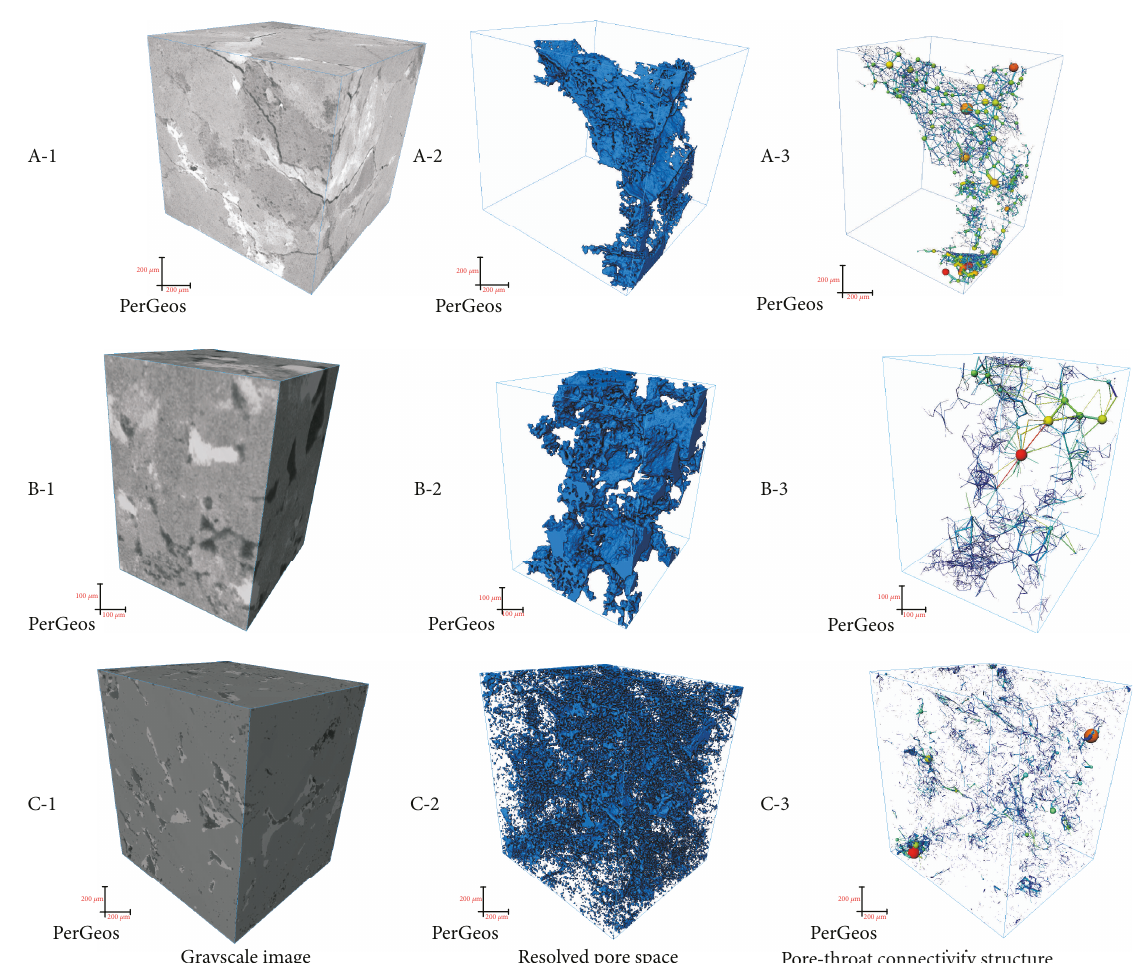
Figure 11: (A-1, B-1, and C-1) Greyscale image, (A-2, B-2, and C-2) dissolved pore space, and (A-3, B-3, and C-3) pore-throat connectivity structure (balls are pores, bars are throats) volumes of the tight sandstone samples. (a) Lithofacies 2, SD24-55, 2982.91m. (b) Lithofacies 3, SD24-55, 2799.78m (c) Lithofacies 8, 2953.89 m (to highlight the pore connectivity, the dissolved pore space and pore-throat connectivity structure of samples A and B are the 3D structure of the interconnected pores. However, the pore diameter, volume, and pore-throat connectivity of mode 8, namely, sample C are low, while C-2 and C-3 demonstrate the characteristics of all the pores and throats).